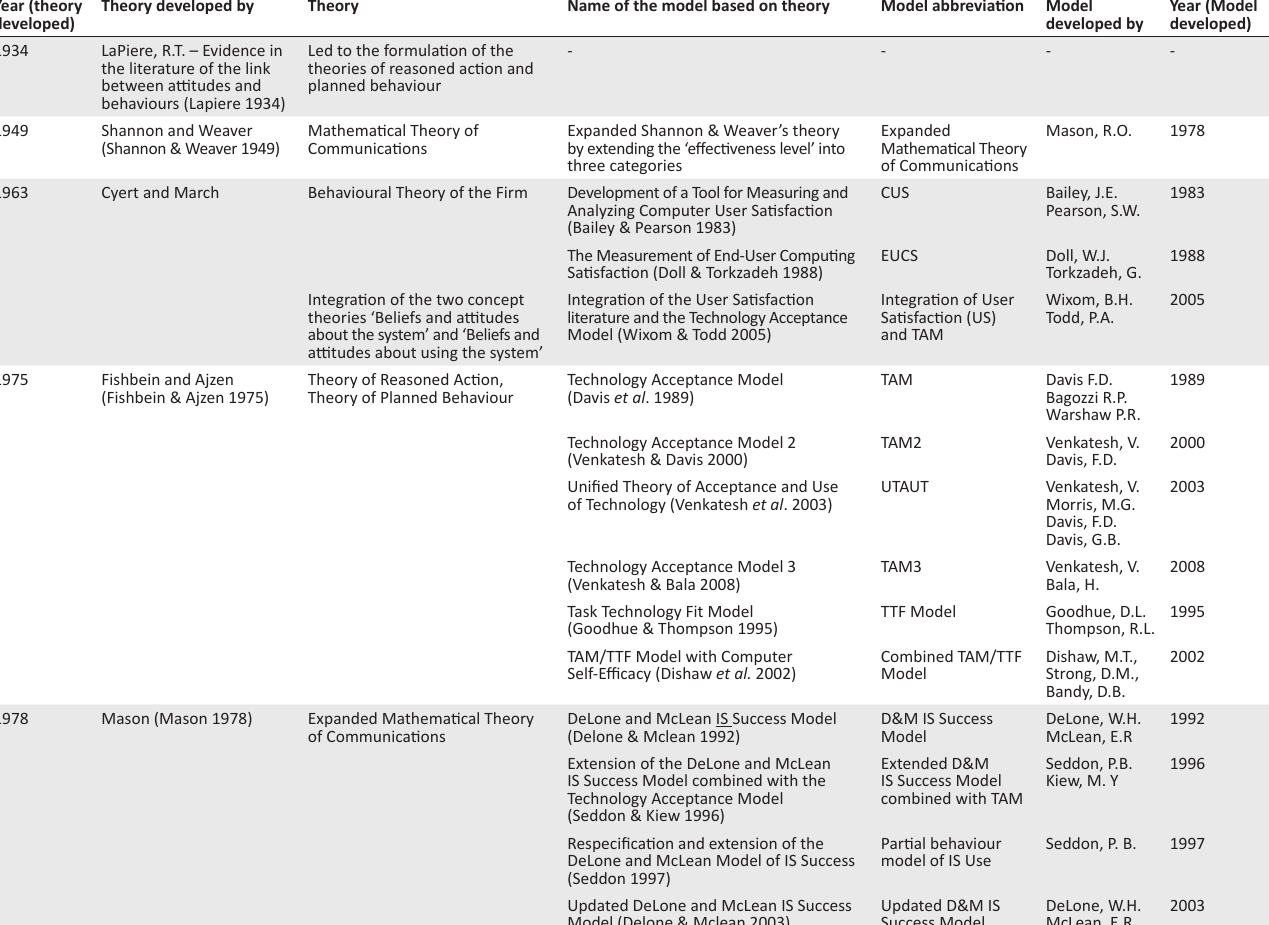
TABLE 1: Synthesised overview of information systems success evaluation models and their underlying theoretical frameworks. Year (theory